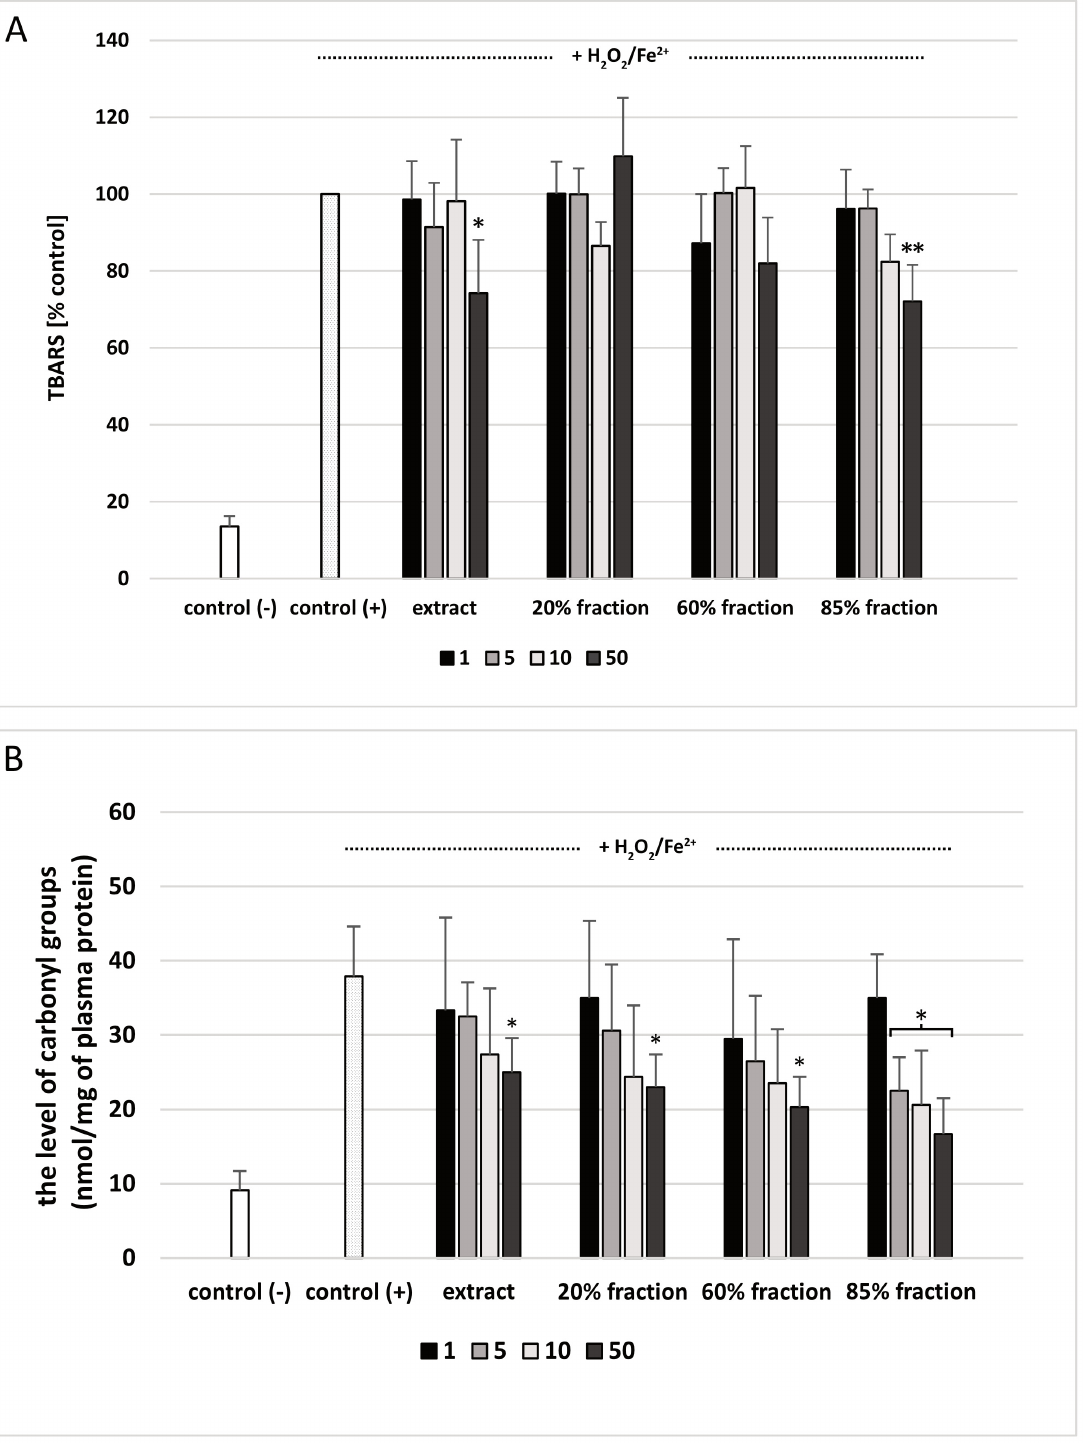
Figure 2. The effect of extract and three fractions (20%, 60% and 85%; concentration range: 1–50 µg/mL; incubation time: 30 min) on lipid peroxidation ( A ) and on protein carbonylation ( B ) in plasma treated with H 2 O 2 /Fe 2+ . Negative control (control ( − )) refers to plasma not treated with H 2 O 2 /Fe 2+ , whereas positive control (control (+)) to plasma treated with H 2 O 2 /Fe 2+ . The differences between control ( − ) and control (+) were statistically signi fi cant. Data represent means ± SD of 5 experiments; * p < 0.05, ** p < 0.01, p > 0.05 (compared with positive control).